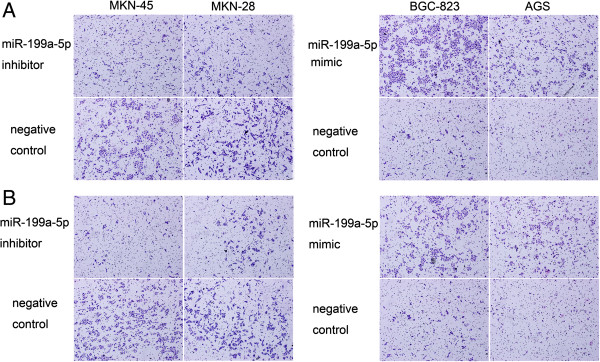
Transwell assay of miR-199a-5p. (A) Gastric cancer cells MKN-45 and MKN-28 were transfected with miR-199a-5p inhibitor and showed reduced migration activity compared with the negative control. BGC-823 and AGS were transfected with miR-199a-5p mimic and showed increased migration activity compared with the negative control. (B) Gastric cancer cells MKN-45 and MKN-28 were transfected with miR-199a-5p inhibitor and showed reduced invasion activity compared with the negative control. BGC-823 and AGS were transfected with miR-199a-5p mimic and showed increased invasion activity compared with the negative control.